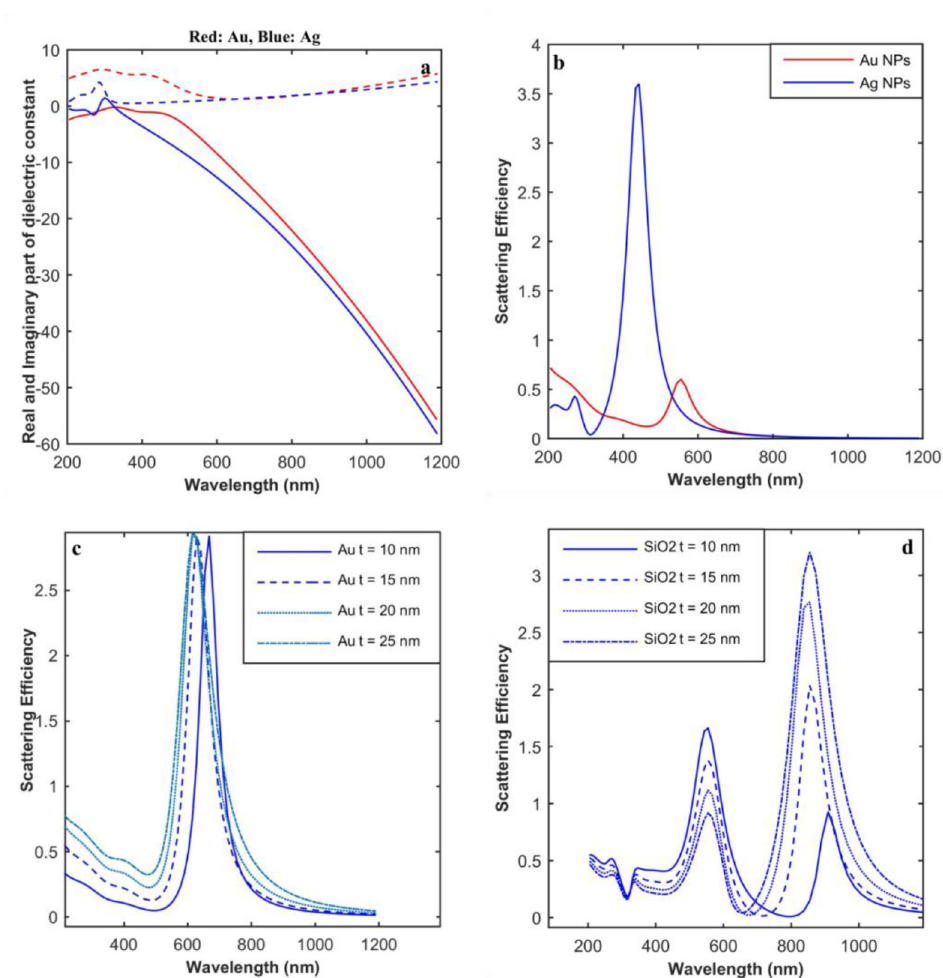
Fig. 3. Optical properties of different NPs: (a) Dielectric constants of NPs (Au, and Ag); (b) Au and Ag NPs with radius 30 nm scattering efficiency; (c) SiO /Au NPs scattering efficiency function of the Au thickness alteration; (d) Au/SiO 2